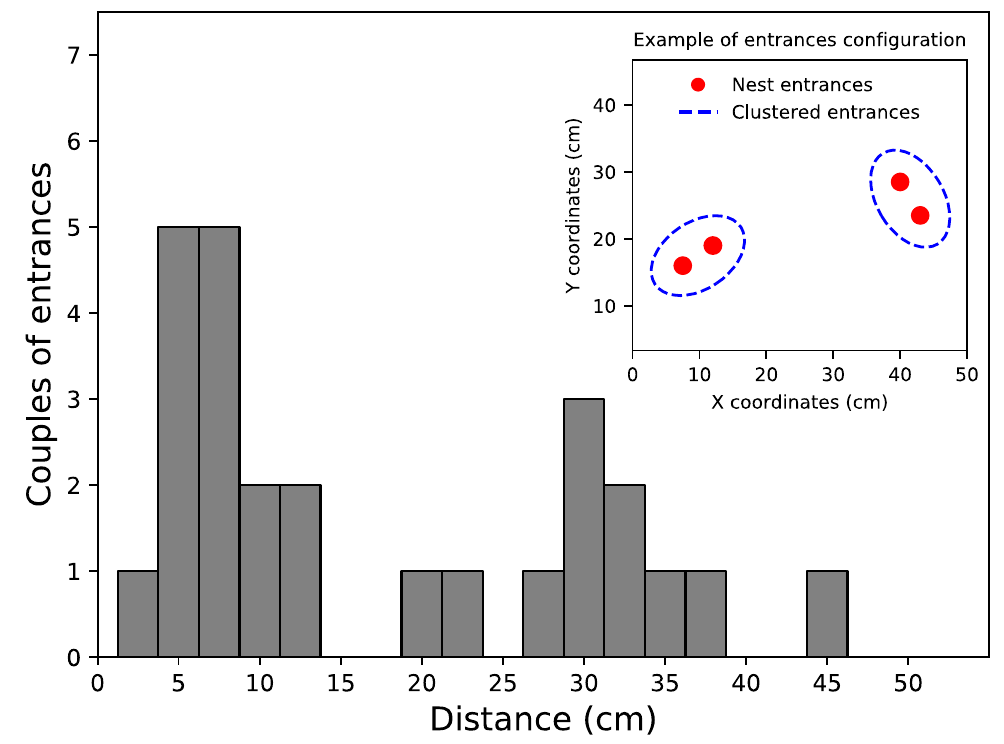
Figure 1. Distribution of the distances measured between all couples of entrances in our field experiments (n = 35) and example of entrances’ configuration observed in the field (inset). The distance values follow a bimodal distribution, indicating that entrances were aggregated into one or two clusters separated by a threshold distance of 15cm.